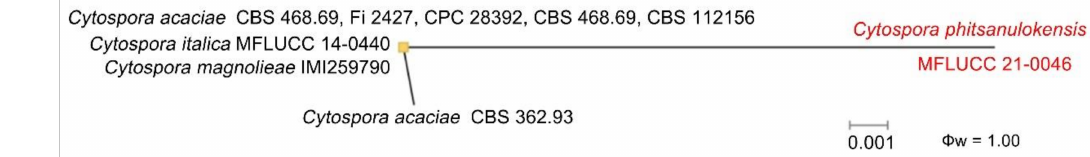
Figure 2. Results of the pairwise homoplasy index (PHI) test of Cytospora phitsanulokensis and closely related species using both LogDet transformation and splits decomposition. PHI test results ( Φ w) < 0.05 indicate significant recombination within the dataset. New species described in this study are indicated in red.